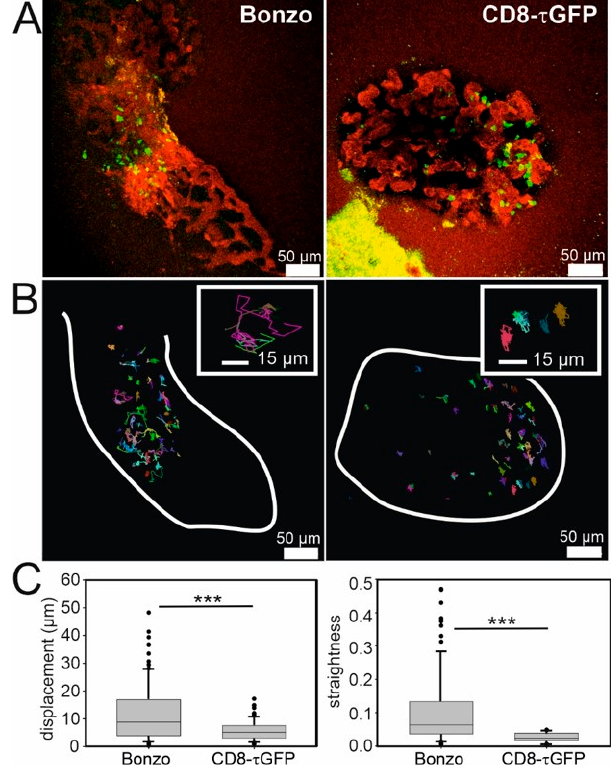
Figure 4. In vivo cell tracking of fluorescently marked lymphocytes rejecting allogenic grafts in the ACE at POD13. ( A ) DBA/2 islets of Langerhans (outlined by stained blood vessels in red) transplanted into the ACE of Bonzo (left) and CD8- τ GFP recipient mice. Green dots represent GFP expressing cells. ( B ) Migration tracks of green cells from (A) over >15 min. White lines indicate outline of the islets. Insets are representative, zoomed sections of the islet. Note the difference of migration patterns. ( C ) Quantitative analyses of displacement (linear distance between a starting and an endpoint of a track, left) and straightness (ratio between displacement and track length, right) from (B). *** p < 0.001. The statistical test used was the Mann-Whitney Rank Sum